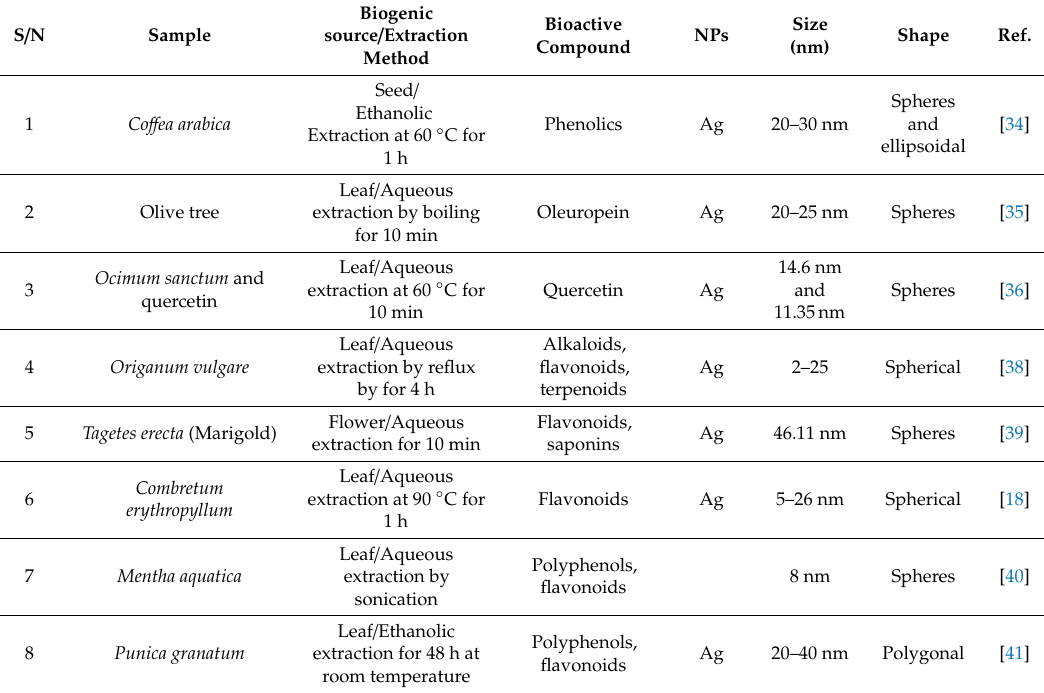
Figure 3. Schematic illustration of three mixing patterns in one-dimensional bimetallic NMs: ( A ) core–shell ( B ) alloyed and ( C ) bamboo-like (adapted with permission from [56], Elsevier, 2013). Table 1. Biogenic synthesis of metal nanoparticles (MNPs) and bimetallic nanoparticles (BMNPs). S / N